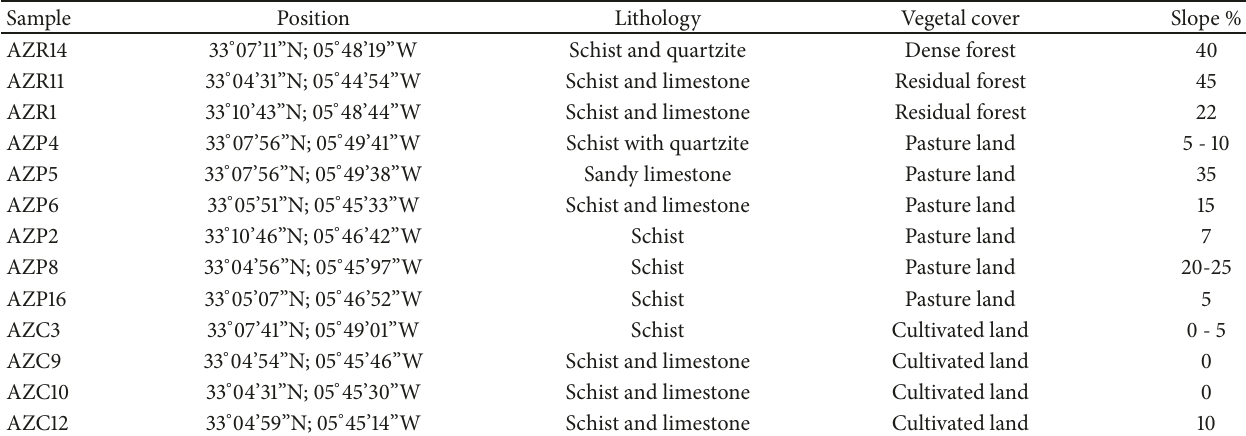
Table 1: Characteristics of the sampled